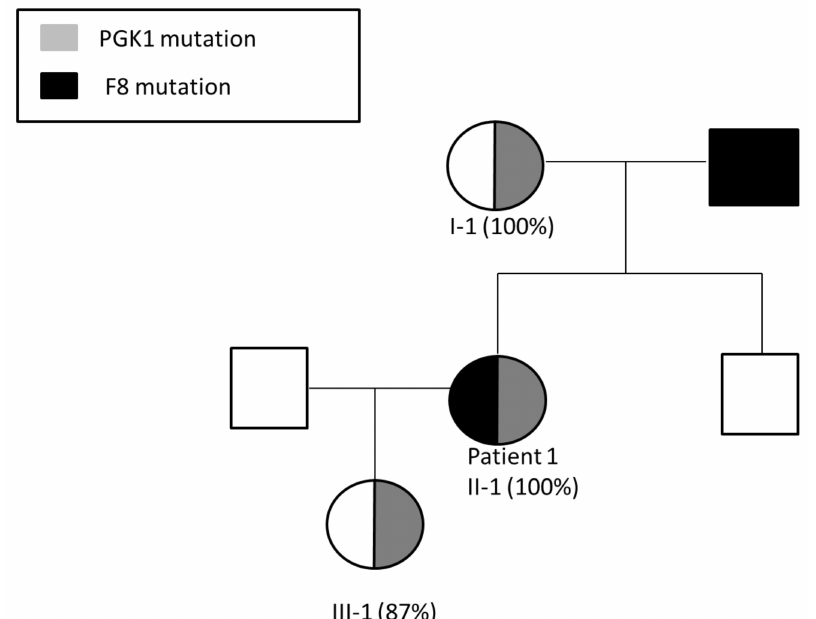
Figure 2. Segregation of F8 and PGK1 mutations in the pedigree of patient 1, demonstrating three generations of skewed inactivation of the X-chromosome bearing the mutant PGK1 gene (%XCI is indicated in parentheses). Patient 1 (II-1), her mother (I-1) and her daughter (III-1) demonstrate skewed inactivation of the same X chromosome. Patient 1 presents with HA phenotype due to a F8 mutation inherited from her